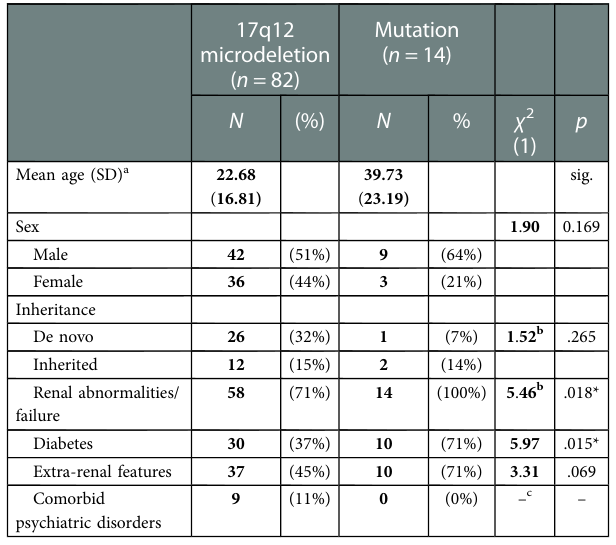
TABLE 3 Characteristics of patients with NDDs.